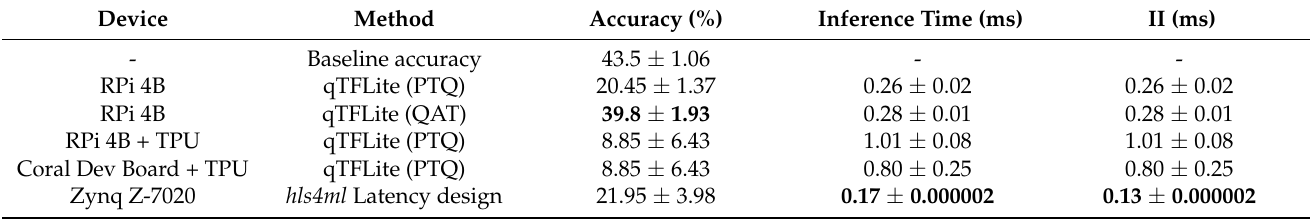
Table 10. CNN1D: Zynq Z-7020 vs. other embedded devices for the ESC-50 dataset. Device